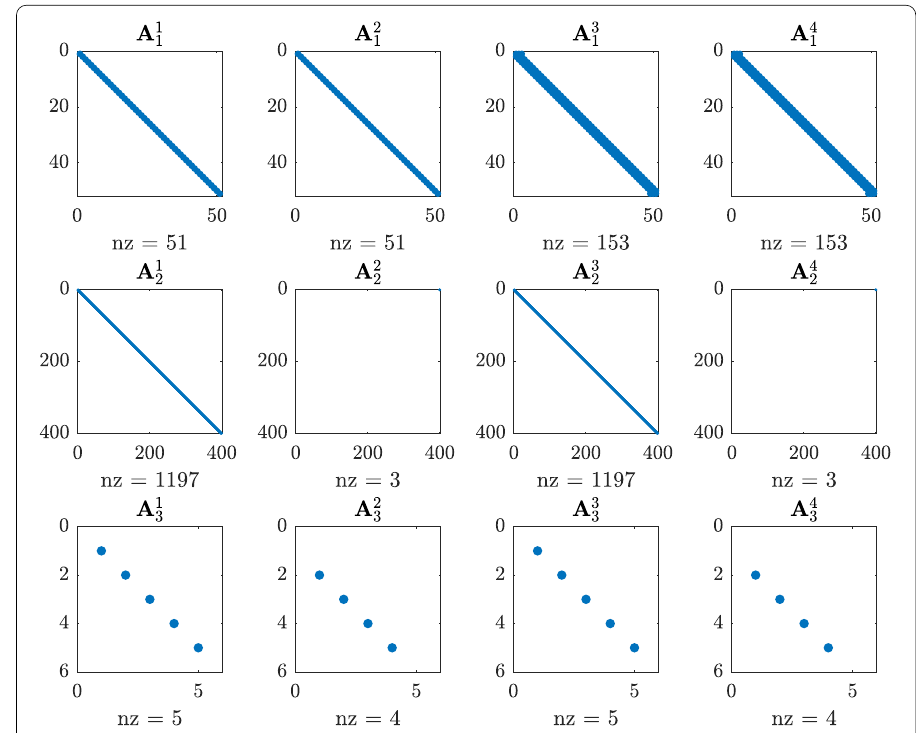
Fig. 6 Sparsity pattern of the discrete PGD operators associated with the separated representation (32), for N x = 51, m + 1 = 400 and M =